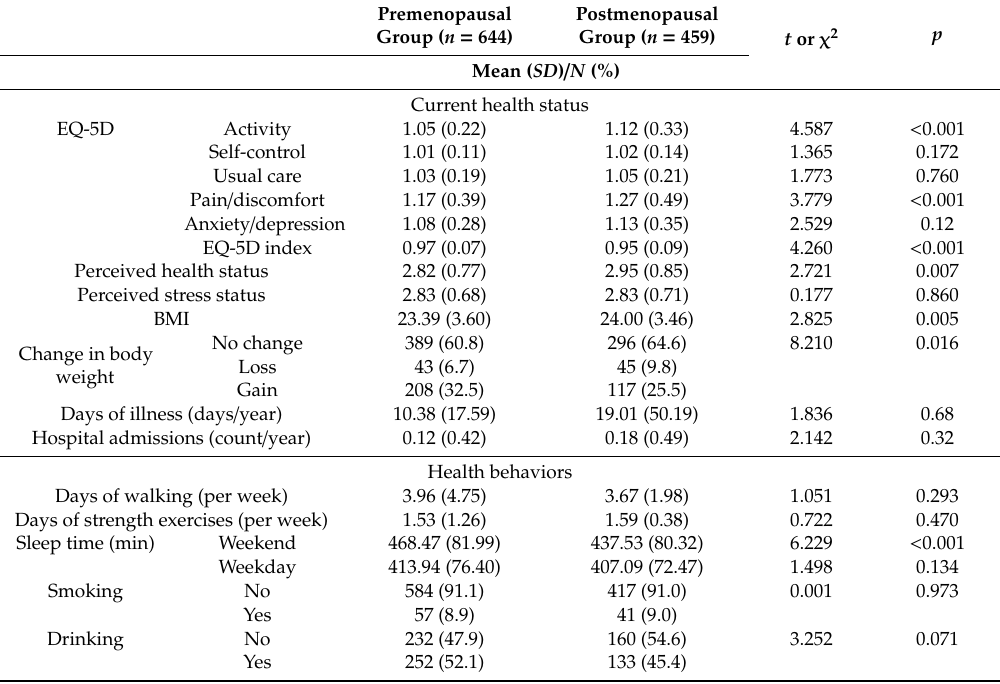
EQ-5D, EuroQol 5-Dimension questionnaire; BMI, body mass